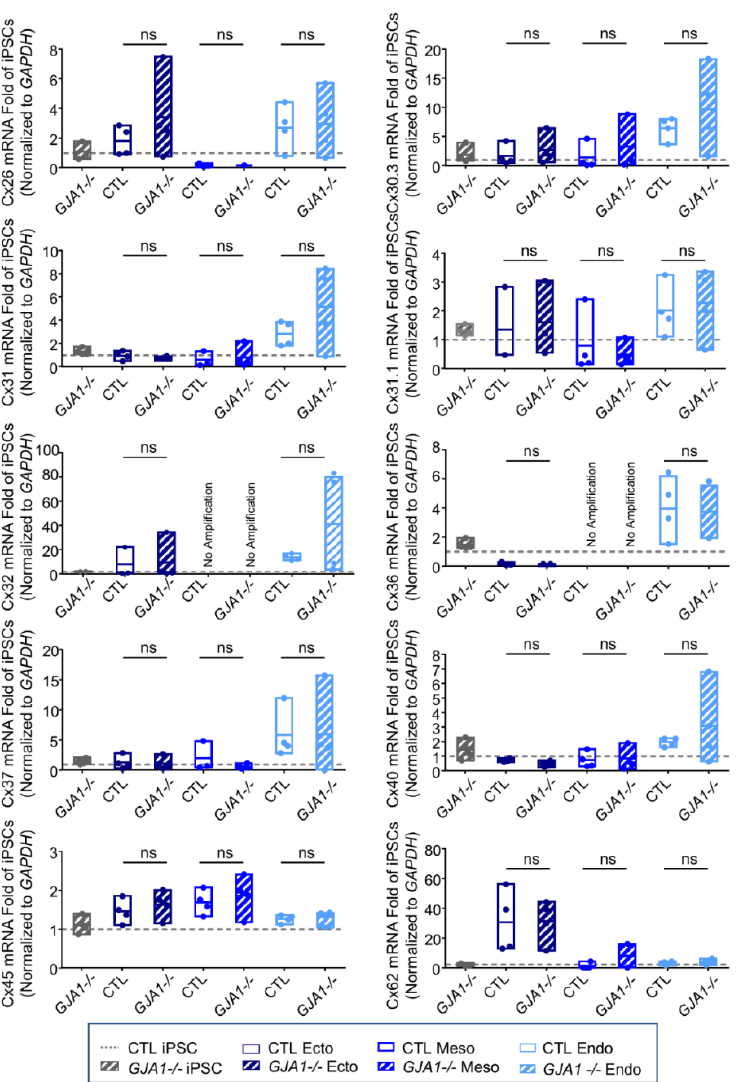
Figure 7. Other connexin isoforms do not compensate for the loss of Cx43 during iPSC lineage commitment. Quantitative RT-PCR (qPCR) screen of mRNA transcripts encoding 10 of the 21 human connexin isoforms in ectoderm, mesoderm, or endoderm directed differentiated from control and GJA1-/- iPSCs. Data represent the standard error of the mean of 4 independent experiments. ns: not significant compared to undifferentiated control iPSCs.